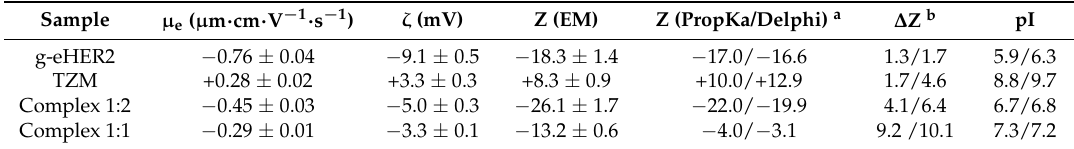
Table 2. Electrostatic properties of the systems under